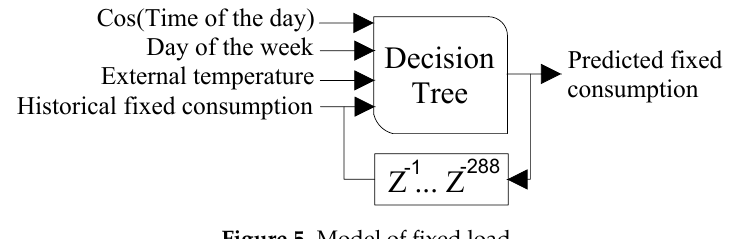
Figure 5. Model of fixed load.